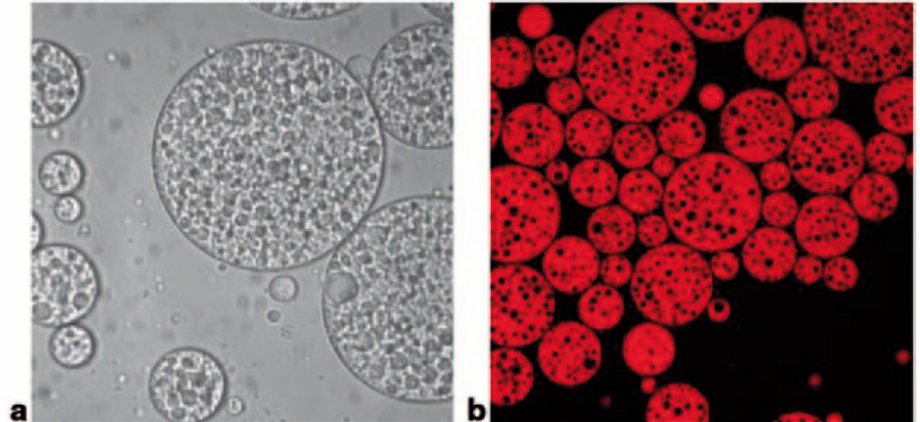
Figure 4. Comparison of a light microscope image ( a ) and a confocal laser scanning microscope (CLSM) image ( b ) of the same double emulsion. The contrast in the CLSM image was achieved by the addition of Nile Red in the oil phase. Figure taken from Bernewitz et al.